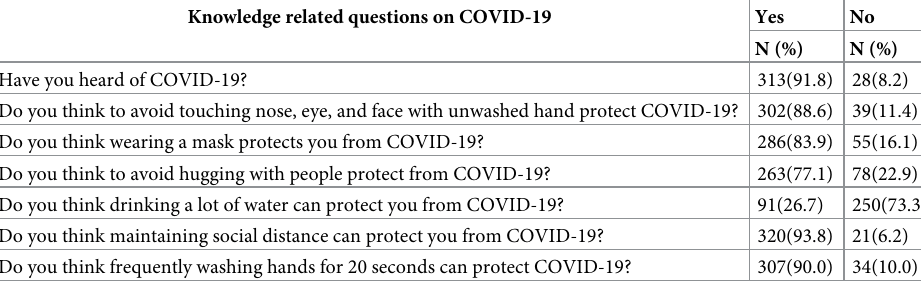
Table 2. Frequency distribution of respondents’ knowledge of prevention from Covid-19, Ethiopia (N =